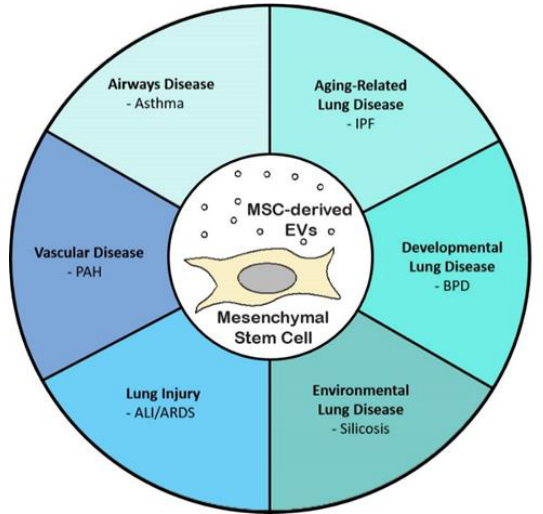
Figure 1. Multipotent mesenchymal stem cell-derived extracellular vesicles (MSC-derived EVs) as